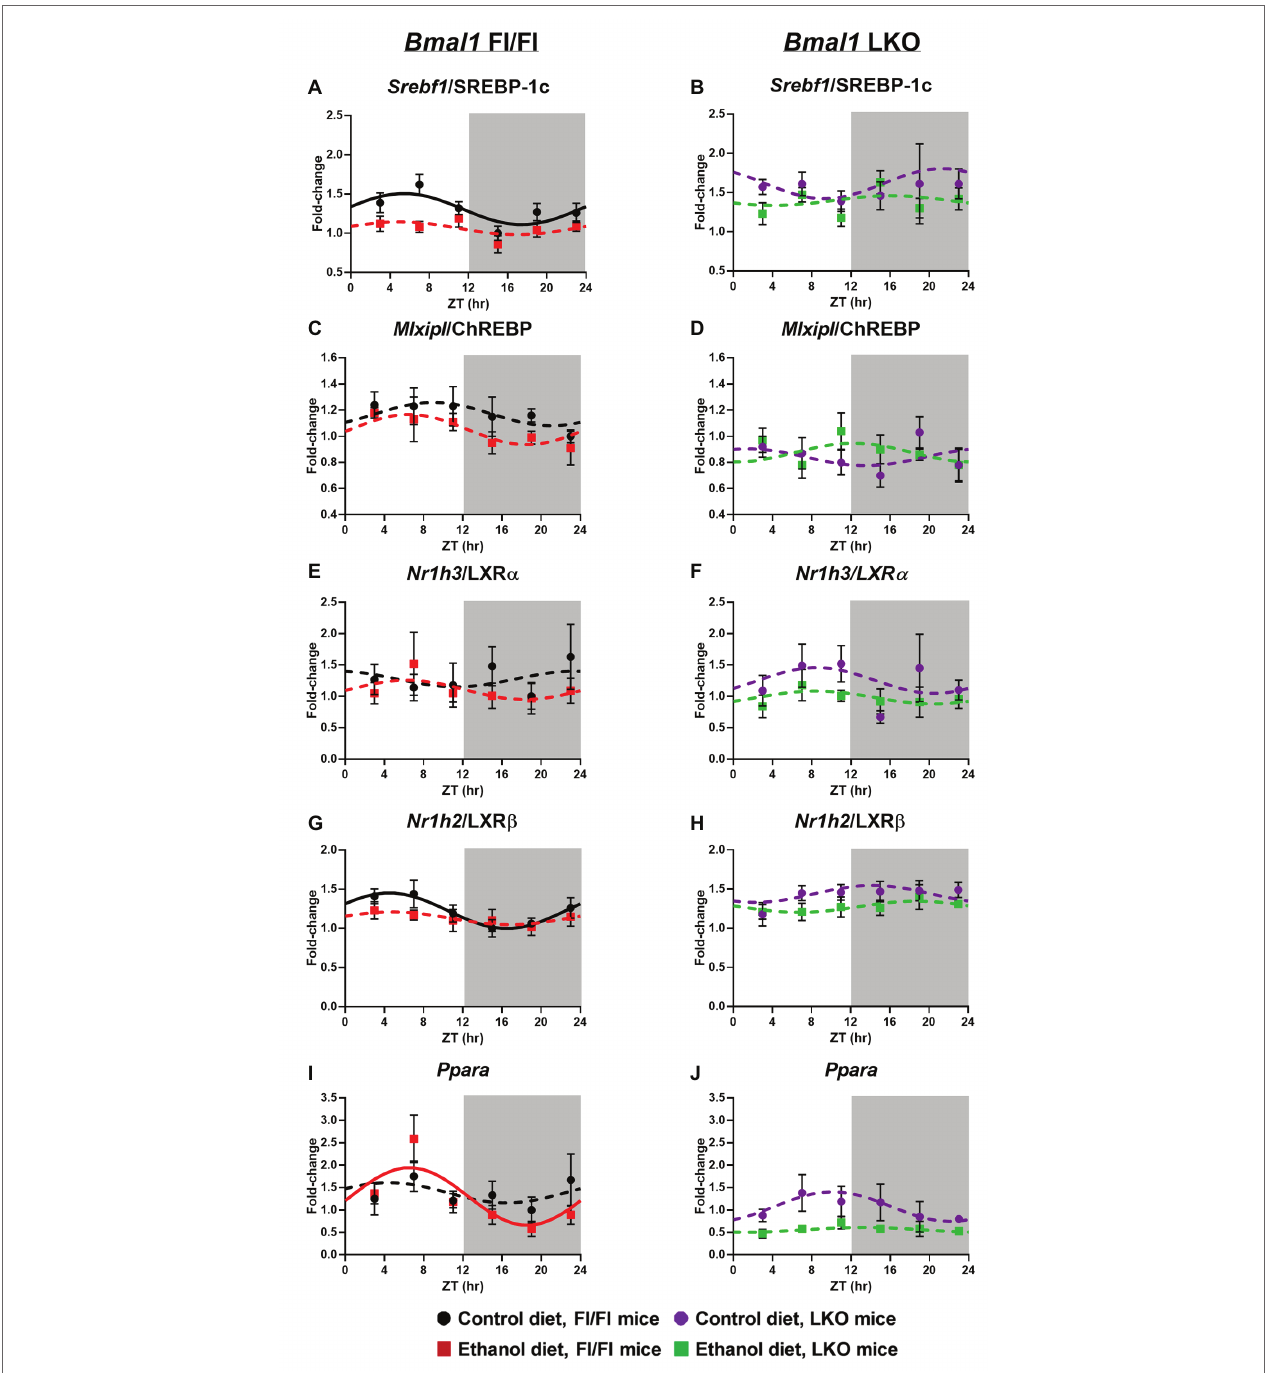
FIGURE 4 | Chronic alcohol and liver clock disruption alter diurnal mRNA rhythms of lipid metabolism transcription factors in the liver. Diurnal mRNA profiles of Sterol regulatory element binding transcription factor 1 ( Srebf1 /SREBP-1C; A,B ), MLX-interacting protein-like/Carbohydrate-responsive element-binding protein ( Mlxipl /ChREBP; C,D ), Nuclear receptor subfamily 1, group H, member 3/Liver X receptor alpha ( Nr1h3 / LXR α ; E,F ), Nuclear receptor subfamily 1, group H, member 2/Liver X receptor beta ( Nr1h2 /LXR β ; G,H ), Peroxisome proliferator-activated receptor alpha ( Ppar α ; I,J ) were measured in livers of control-fed (black) and alcohol- fed (red) Bmal1 Flox/Flox (Fl/Fl) and control-fed (purple) and alcohol-fed (green) Bmal1 liver-specific knockout (LKO) mice at ZT 3, 7, 11, 15, 19, and 23 (ZT 0: lights on/inactive period, ZT 12: lights off/active period, gray area) by RT-PCR. Data are presented as a fold-change to the Bmal1 Fl/Fl control diet trough time-point and normalized to Ppia . Cosinor analysis was performed using a nonlinear regression module in SPSS. Data are expressed as mean ± SEM for n = 4–8 mice/genotype/ diet/time point. Solid lines indicate rhythmic mRNA levels and a significant cosine fit, whereas dashed lines indicate arrhythmicity and a non-significant cosine fit. Results for Cosinor and ANOVA analyses are provided in Supplementary Tables 3 and 4 ,